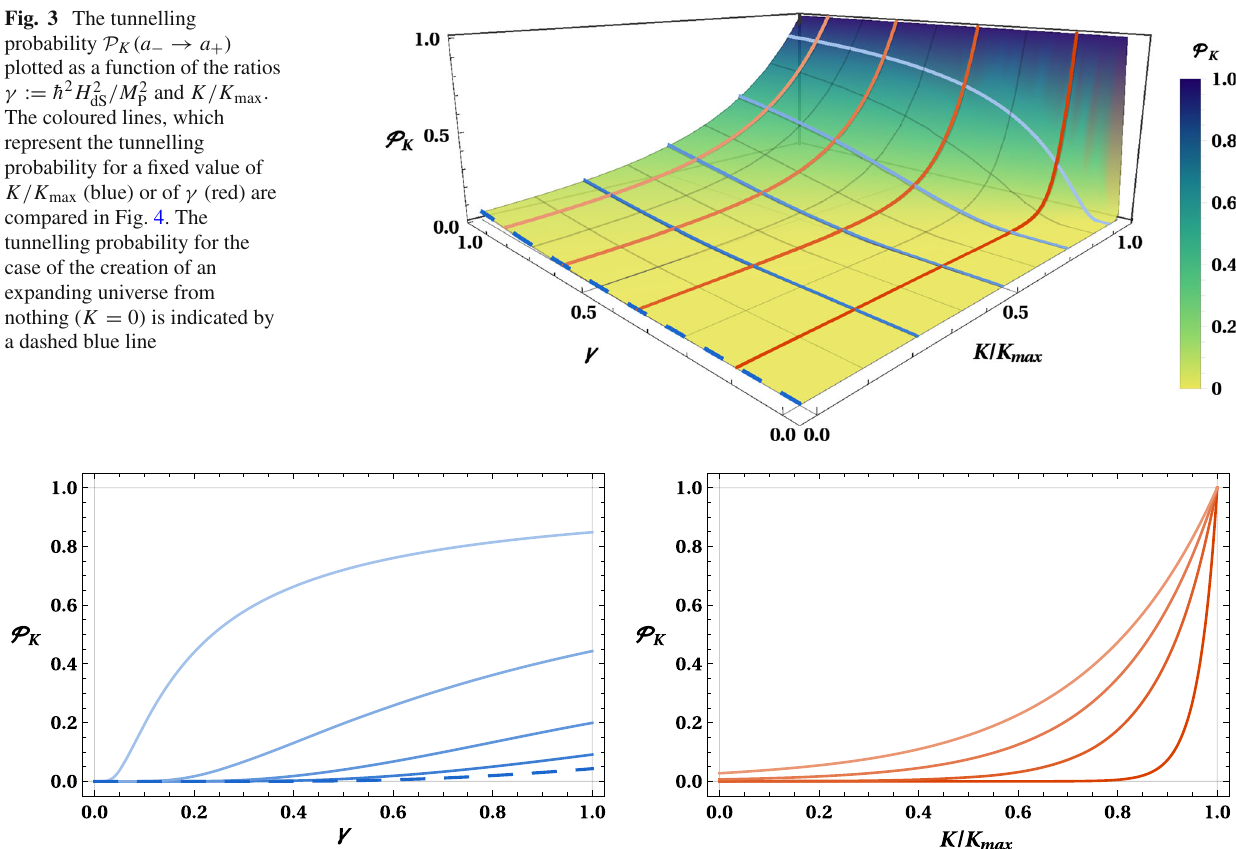
Fig. 3 The tunnelling probability P K ( a − → a + ) plotted as a function of the ratios γ := ¯ h 2 H 2 / M 2 and K / K max . dS P The coloured lines, which represent the tunnelling probability for a fixed value of K / K max (blue) or of γ (red) are compared in Fig. 4. The tunnelling probability for the case of the creation of an expanding universe from nothing ( K = 0) is indicated by